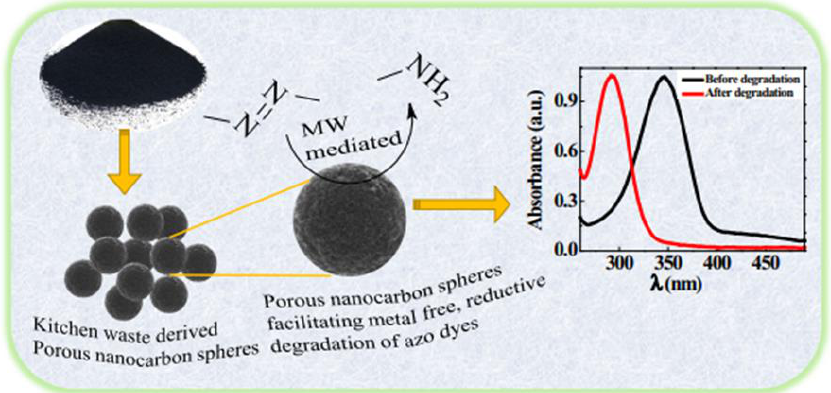
Figure 27. Porous nanocarbon spheres derived from kitchen waste for metal-free azo dyes degrada- tion. Adapted with permission from ref. [135].